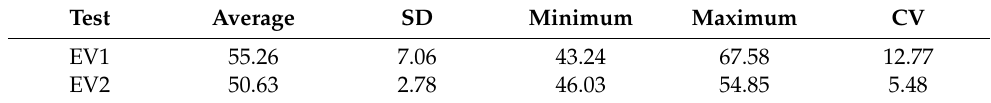
Table 6. The average value of the percentage distribution of the weight on the left leg.